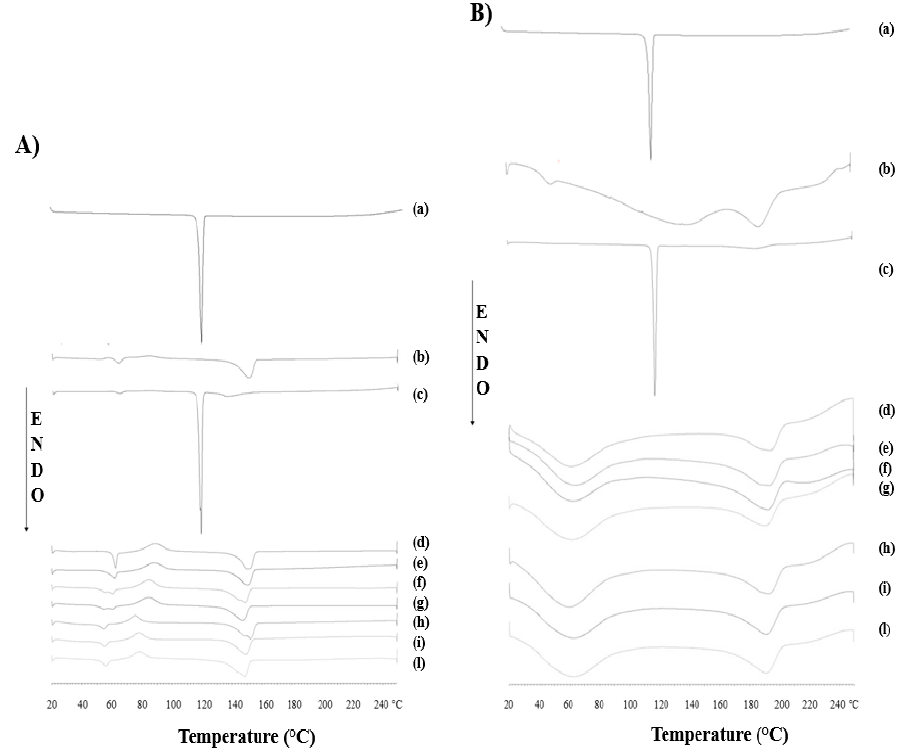
Figure 5. DSC curves of ( A ) Melatonin (a), PLA polymer (b), physical mixture MEL + PLA polymer (c), empty-PLA nanofibers (d), Melatonin-loaded PLA nanofibers with different concentration of drug 0.1% w/w (e), 0.3% w/w (f), 0.5% w/w (g), and Melatonin-loaded PLA nanofibers with Tween ® 80 and different concentration of drug 0.1% w/w (h), 0.3% w/w (i), 0.5% w/w (l); and ( B ) Melatonin (a), PVA polymer (b), physical mixture MEL+PVA polymer (c), empty-PVA nanofibers (d), Melatonin-loaded PVA nanofibers with different concentration of drug 0.1% w/w (e), 0.3% w/w (f), 0.5% w/w (g), and Melatonin-loaded PVA nanofibers with Tween ® 80 and different concentration of drug 0.1% w/w (h), 0.3% w/w (i), 0.5% w/w (l).